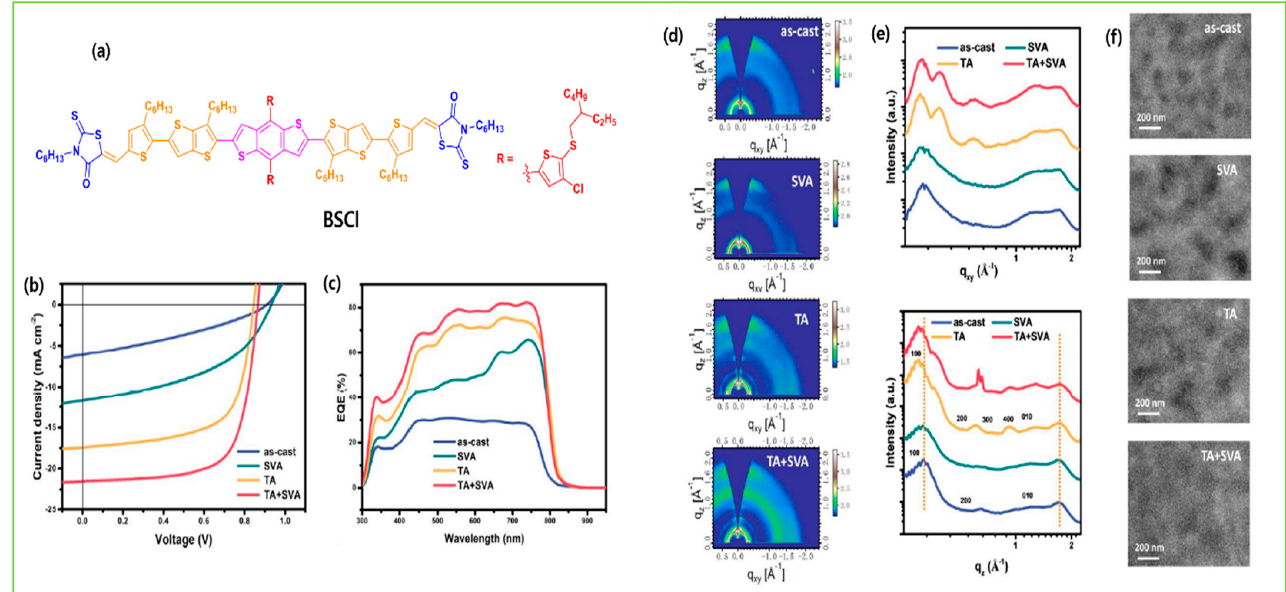
Figure 18. ( a ) Chemical structure of BSCl donor. ( b , c ) J-V and EQE curves for SMSCs based on BSCl:IDIC-4Cl blend films with different post-treatments under AM 1.5 G irradiation. ( d ) Two-dimensional GIWAXS graphs with different post-treatment. ( e ) Corresponding curves of 2D GIWAXS patterns and ( f ) TEM images. Adapted with permission from [124]. Copyright 2020, Royal Society of Chemistry.